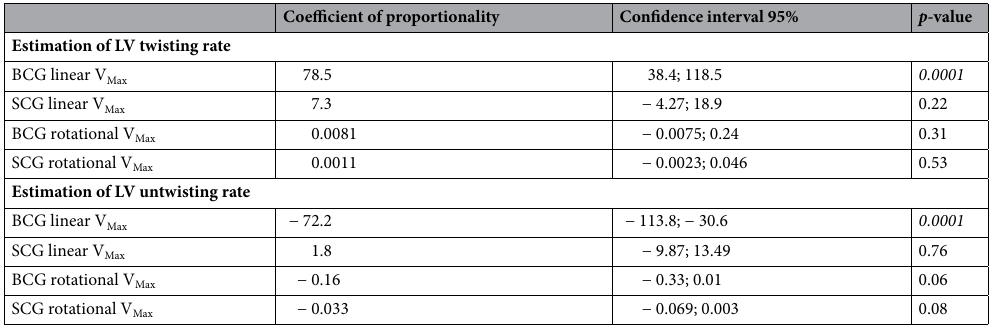
Table 4. Estimation of LV twisting rate and untwisting rate through metrics secured from the SCG and BCG signals. Generalized linear model. Variables taken into the model were: SCG linear V Max , BCG linear V Max , SCG rotational V Max , BCG rotational V Max . Outcomes: LV twisting rate (°/s) and LV twisting rate (°/s). V max maximal velocity (mm/s/m 2 ), BCG ballistocardiography, SCG seismocardiography, LV left